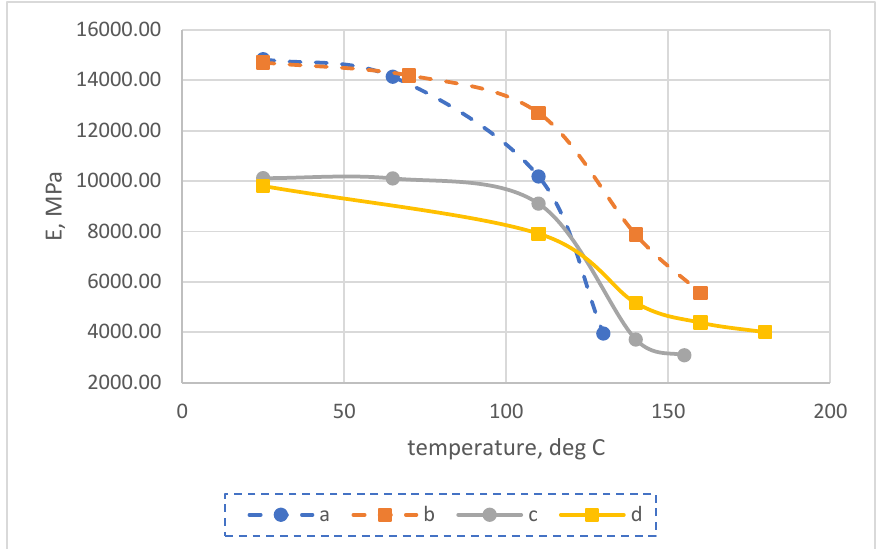
Figure 9. Dependence of elastic modulus on temperature: (a) calculated for the monolayer before exposure at temperature; (b) calculated for the monolayer after soaking at temperature; (c) experi- mental for the fiberglass sample before exposure at temperature; (d) experimental for the fiberglass sample after aging at the temperature.